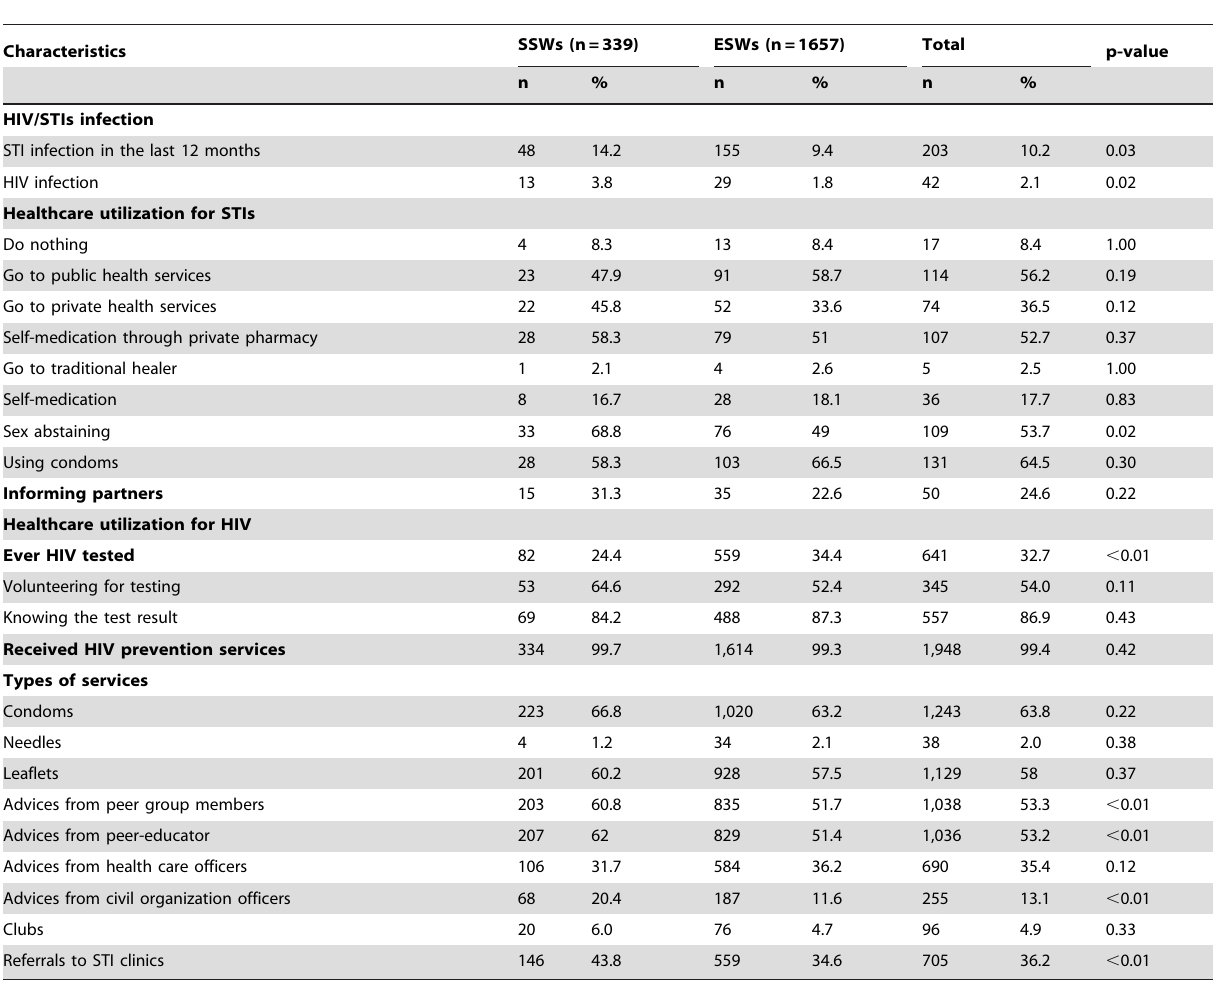
Table 2. HIV prevalence and healthcare utilizations for HIVby type of sex work.